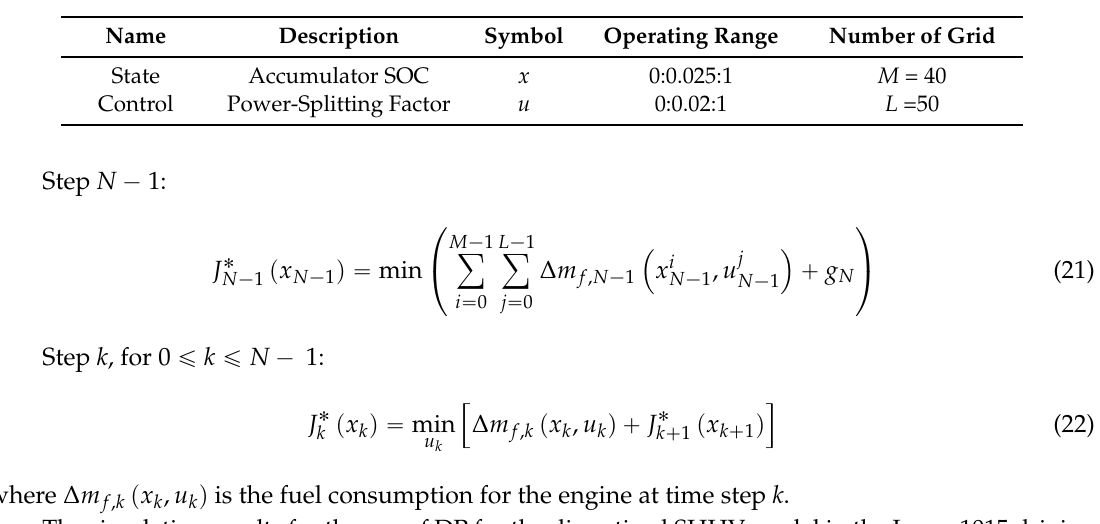
Table 3. State and Control Input